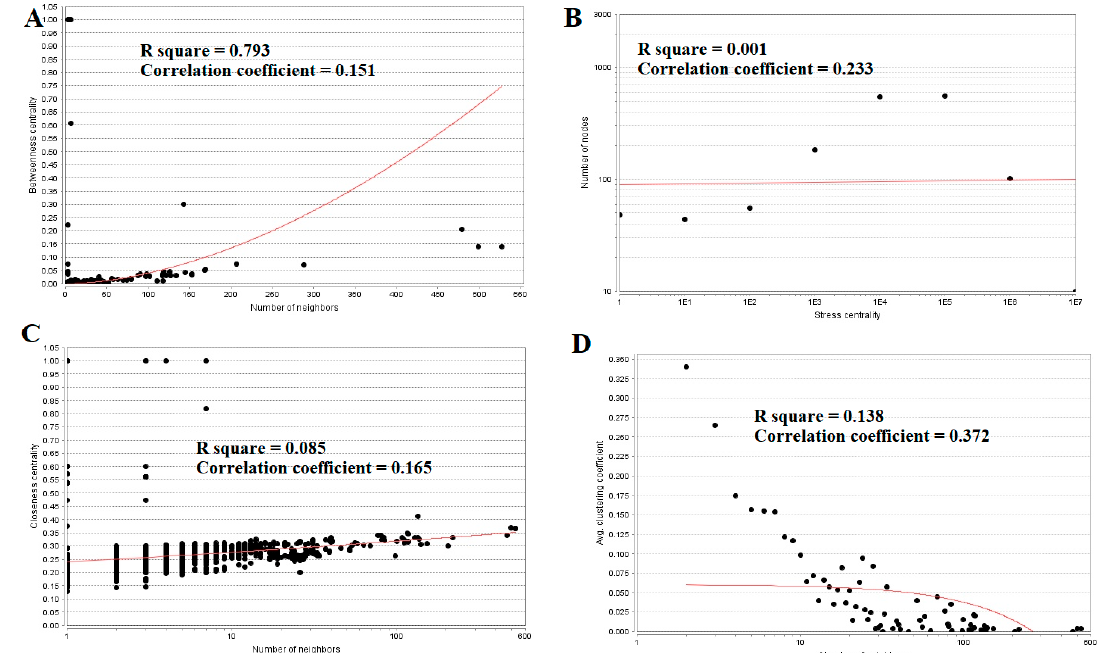
Figure 8. Regression diagrams for up-regulated genes (( A ) Betweenness centrality; ( B ) Stress centrality; ( C ) Closeness centrality; ( D ) Clustering coefficient). The red straight lines and the red curve lines: regression lines. Diagnostics 2019 , 9 , 39